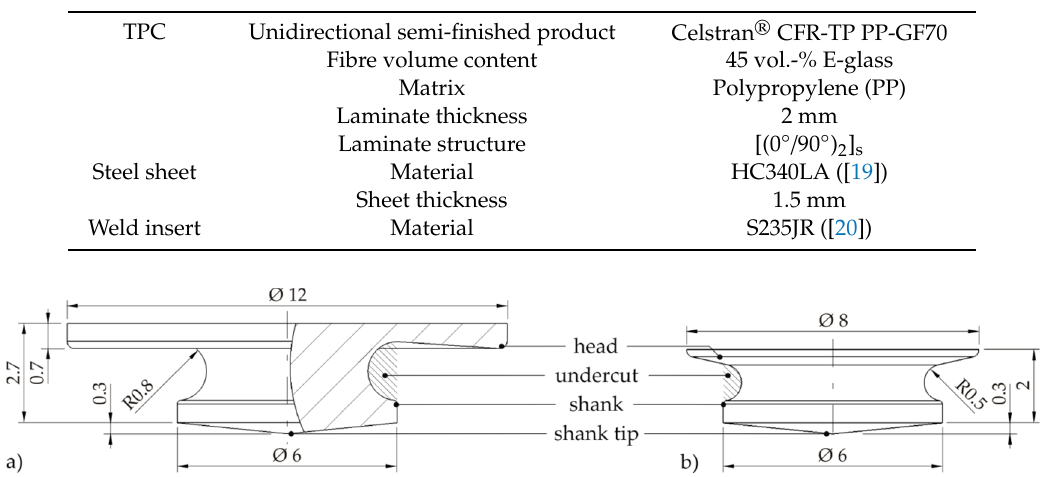
Table 2. Material specification.